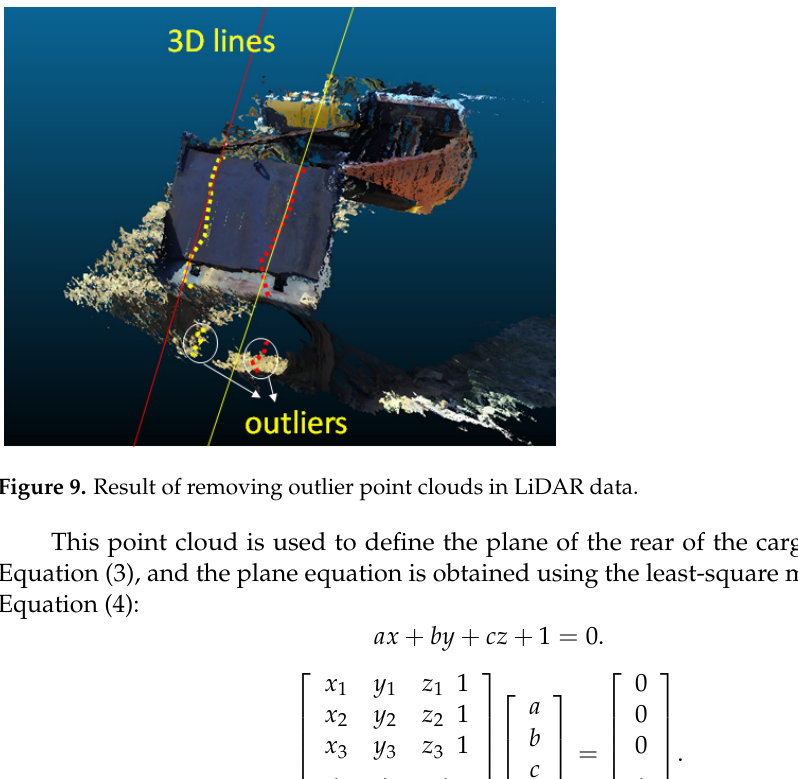
Figure 8. A method to detect the door of a dump truck cargo box using two LIDAR sensors. The points on the plane have the same normal vector, and the dot product with the camera z-axis is close to − 1. The normal vector is computed with two LIDAR point clouds.